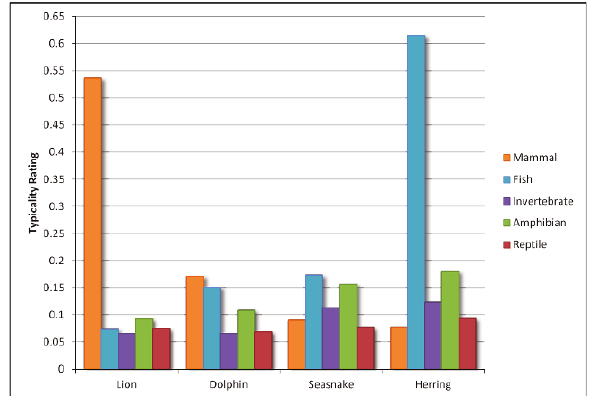
Figure 5. Conceptual Space model classification results for four animals. Five of the seven available animal type categories are shown, for the pur- pose of clarity. All animals are classified correctly, except seasnake (Reptile): this is classed as a fish, although the rating for amphibian is similarly high.